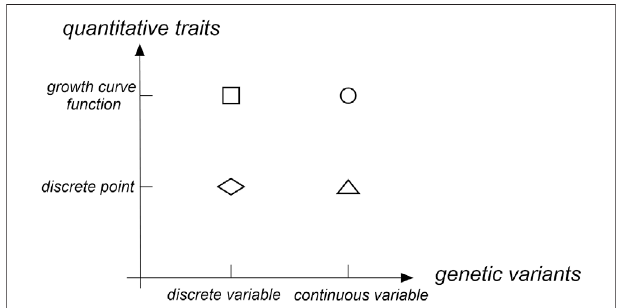
FIGURE 1 | Research status on quantitative traits and genetic